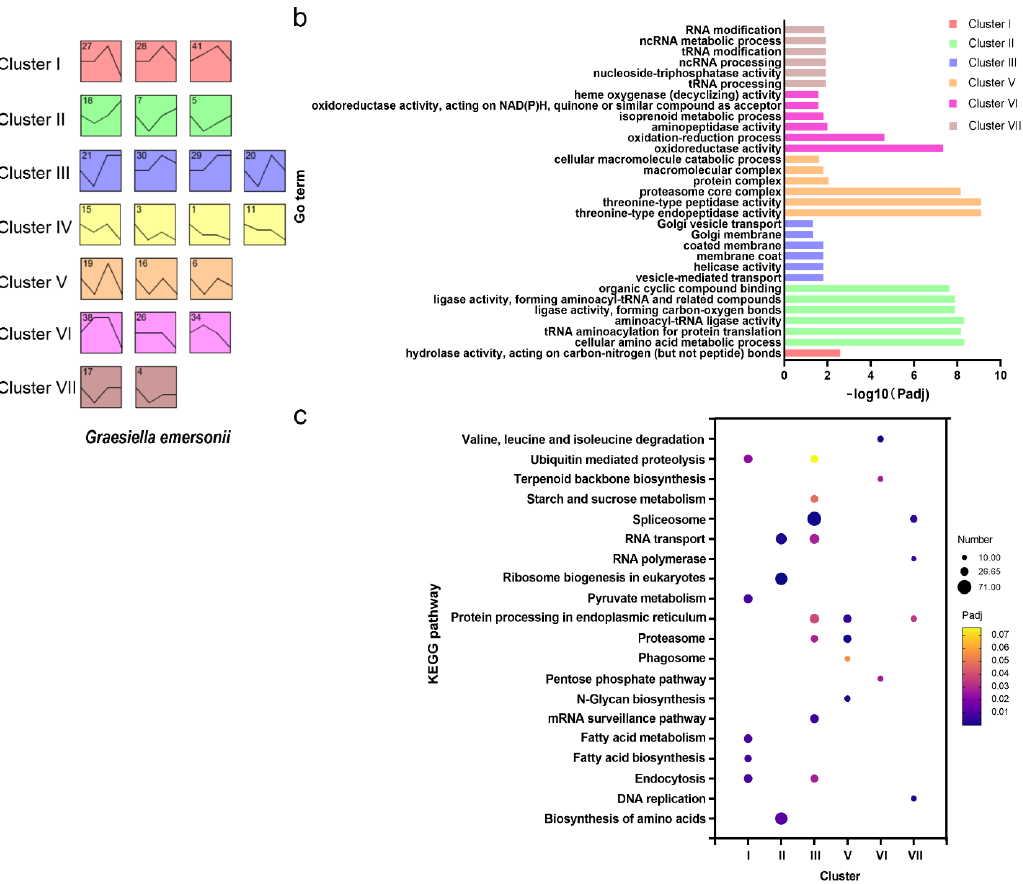
Figure 3. STEM trend and functional enrichment analysis of microalga G. emersonii during infection. ( a ) Seven clusters by STEM analysis; ( b ) GO terms enrichment analysis; ( c ) KEGG pathway enrichment analysis.